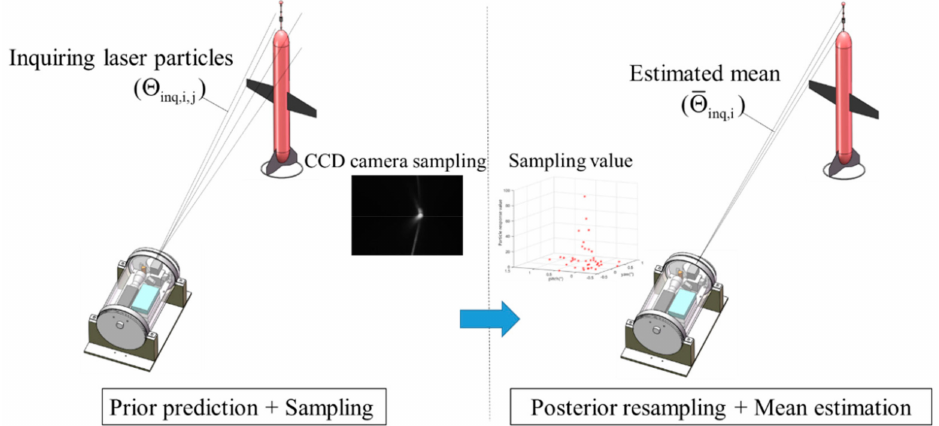
Figure 6. Schematic of the proposed tracking